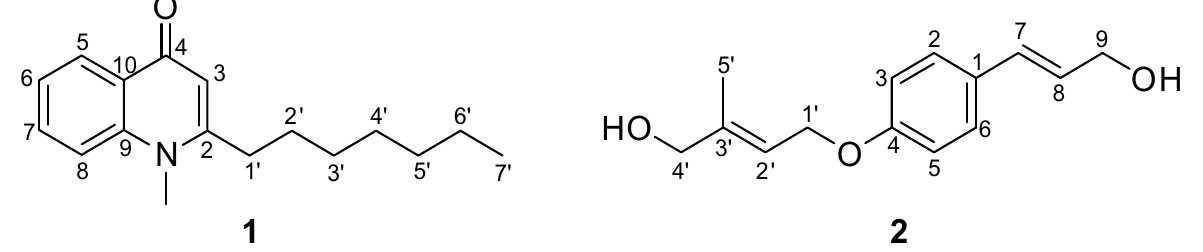
Figure 3. Chemical structure of isolated compounds 1 and 2 from T. ruticarpum . Compound 1 was obtained as a white crystal and showing a positive reaction with Dragendorff’s reagent test. The molecular formula of 1 was determined to be C 17 H 23 NO based on the ion at m / z 258.1 [M + H] + in the fast atom bombardment mass